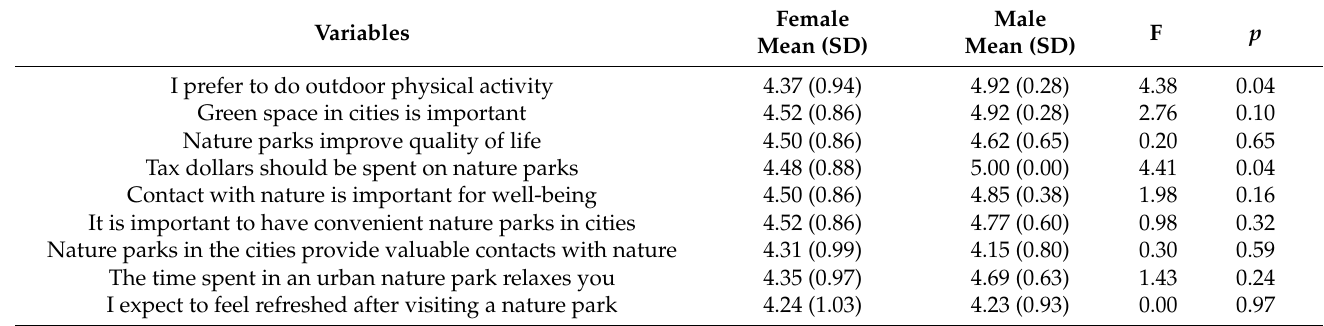
Table 3. Participants’ answers to the questionnaire and differences between sexes